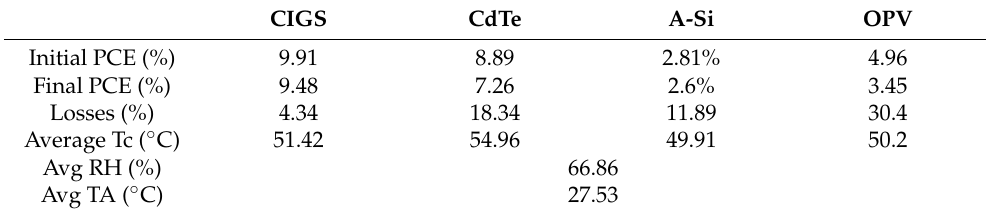
Table 7. PCE losses for PV technologies in PVMS2 after four months.